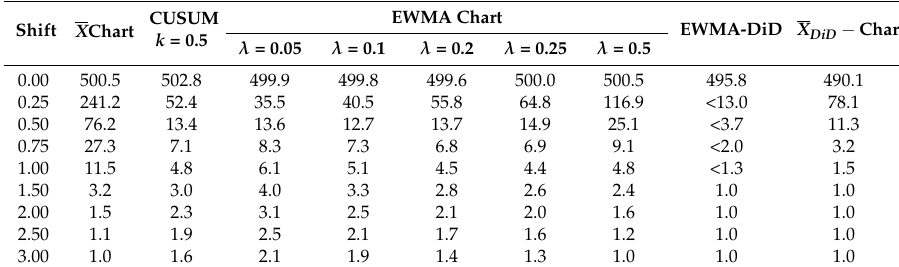
Table 4. Comparison of different control charts.